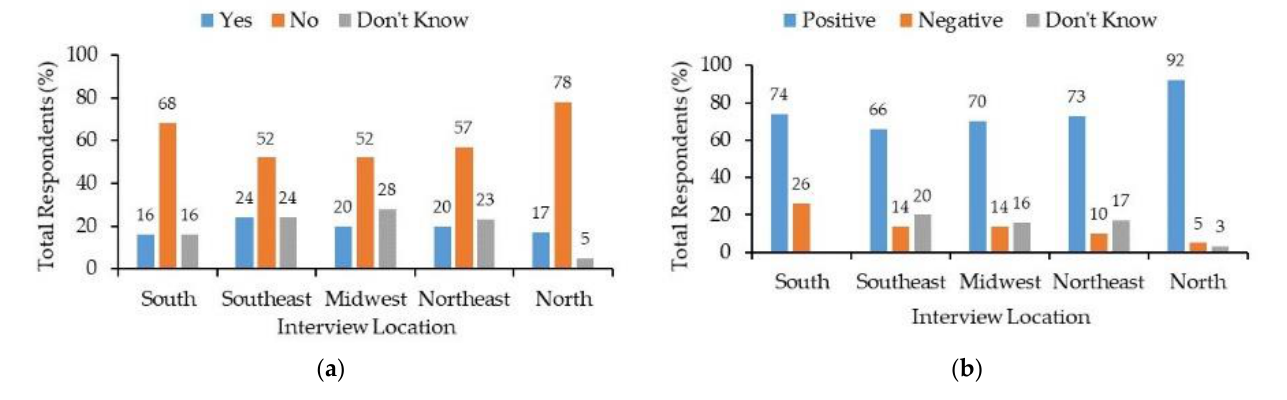
Figure 4. Perception in relation to environmental instability ( a ), perception of changes in the landscape ( b ), according to the total number of interviewees by region. Source: elaborated by the author.